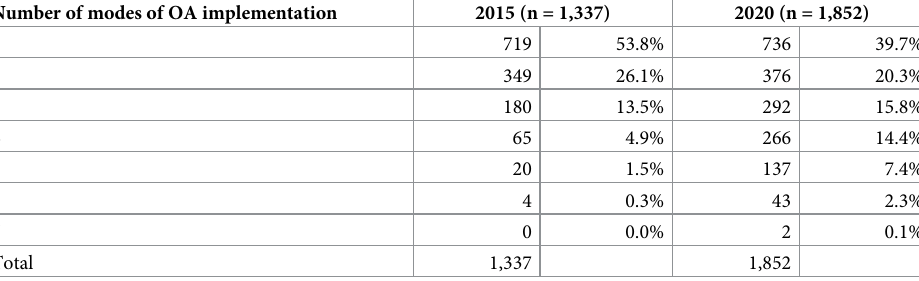
Table 4. Number of modes of open access (OA)